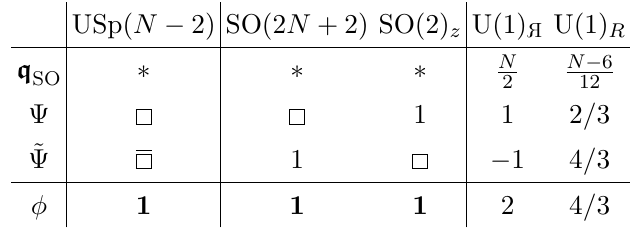
CFT that is expected to generate SO CFT is partially flipped, see figure SO